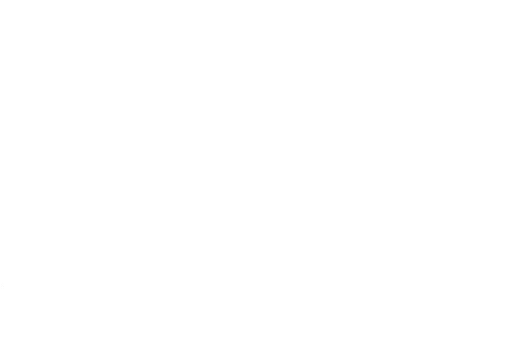
Figure 4. Number of BFP-MSCs harvested from disks and re-plated in 12-well culture plates for 72 h. Bars represent the number of live cells relative to those plated upon detachment from disks.